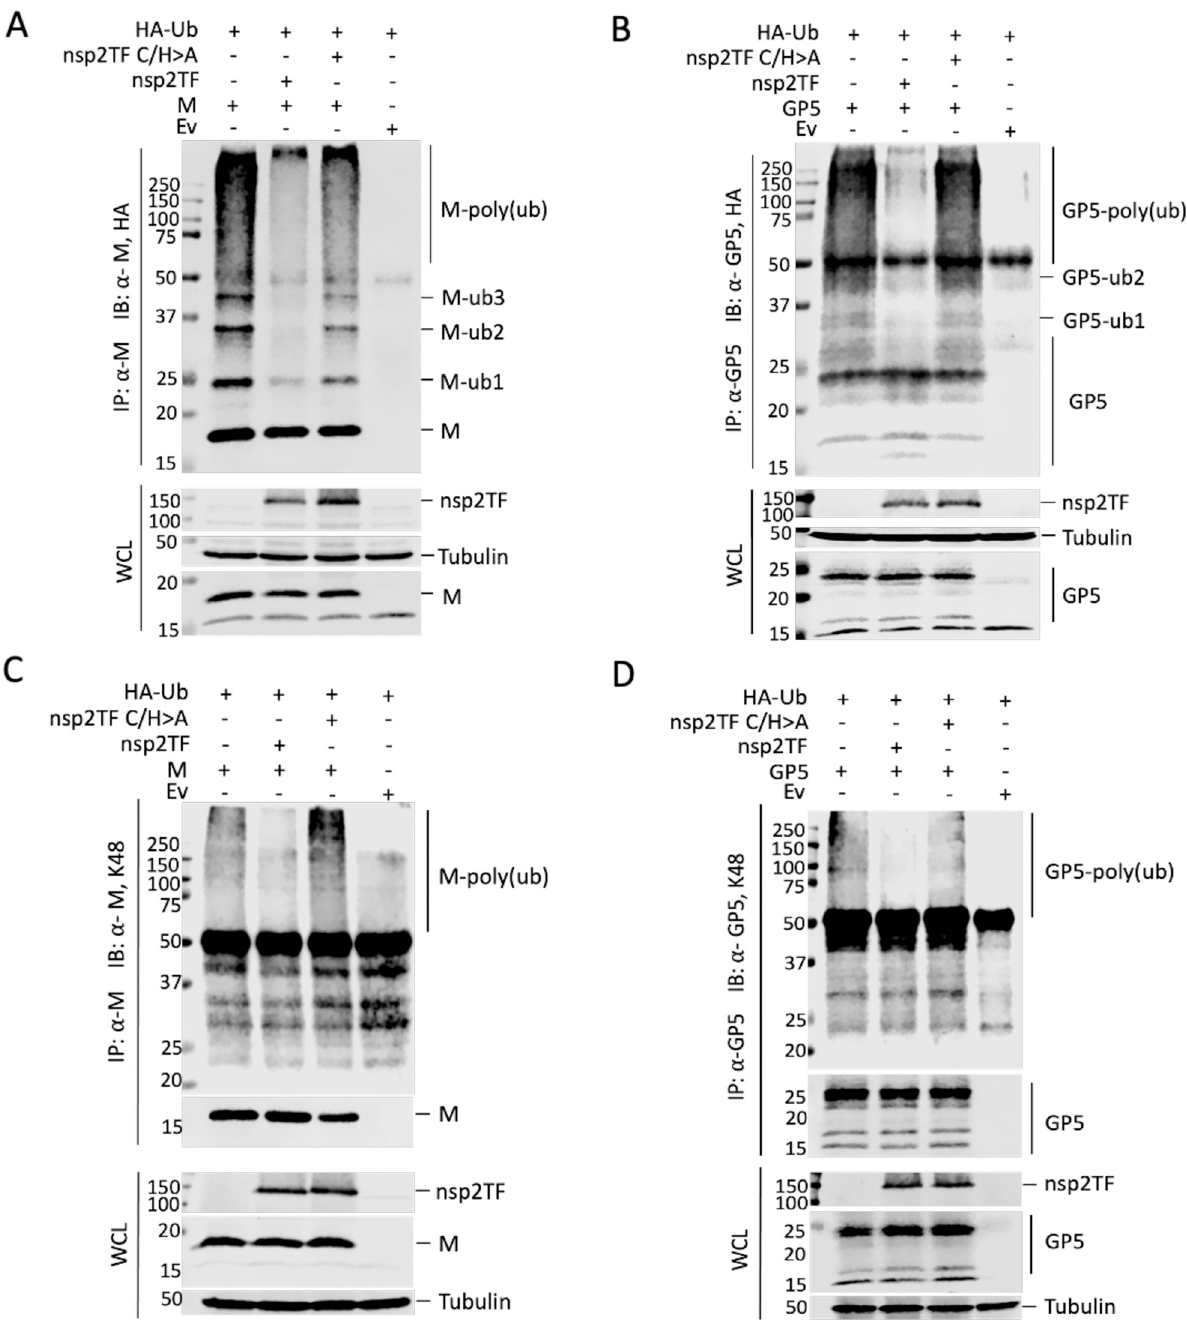
Fig 5. Nsp2TF antagonizes polyubiquitination of GP5 and M protein. HEK-293T cells were co-transfected with plasmids expressing HA-Ub, M protein ( A and C ) or GP5 ( B and D ) and a plasmid expressing nsp2TF or the PLP2 catalytic sites mutant (nsp2TF-C/H > A). Cell lysates were collected at 48 h post transfection. IP was performed with anti-M pAb ( A and C ) or anti-GP5 pAb ( B and D ) and the membrane was probed with anti-HA mAb ( A and B ), a pAb recognizing anti-K48-linked polyubiquitin ( C and D ), or a viral protein-specific antibody. IP: immunoprecipitation; IB: immunoblotting; WCL: whole cell lysates; Ev: empty vector.